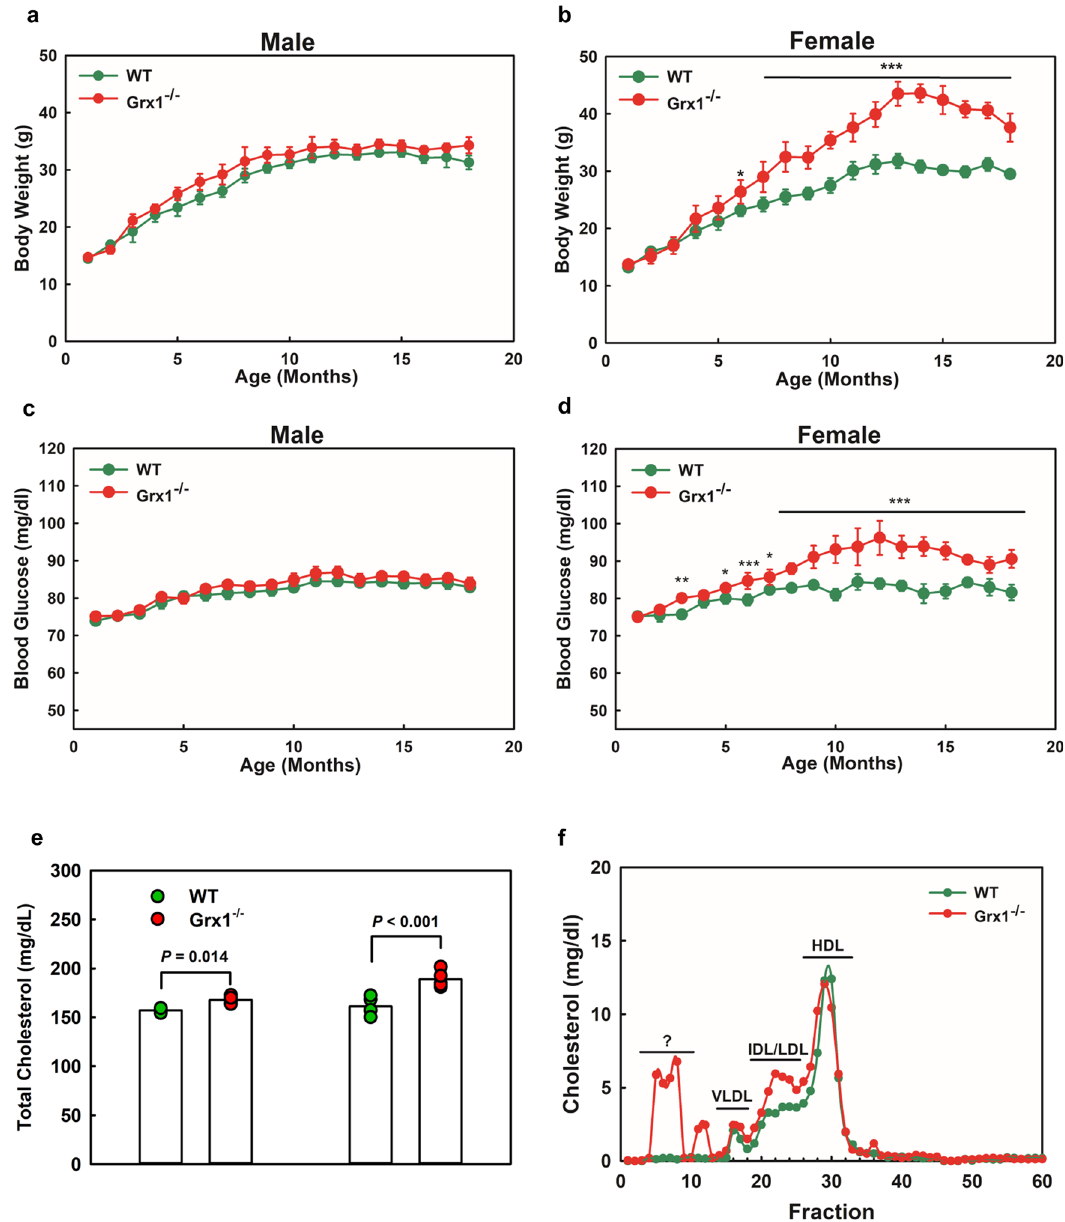
Fig. 1 Characterization of metabolic phenotypes of chow-fed aged male and female Grx1 -/- mice as compared to age-matched male and female C57BL/ 6 J mice. a – b Body weights. c – d Fasting blood glucose levels. e – f Total plasma cholesterol levels and plasma lipoprotein pro fi les in female WT ( n = 5) and Grx1 -/- mice ( n = 4) at 18 months of age. Lipoprotein pro fi les were generated from pooled plasma samples. All data are expressed as mean ± S.D., n = 5 – 6 mice per group for a – f ; *One-way ANOVA followed by Fisher ’ s Least Signi fi cance Difference test was used to compare the mean values between experimental groups. P < 0.05; ** P < 0.01; *** P < 0.001; Source data are provided as a Source Data fi